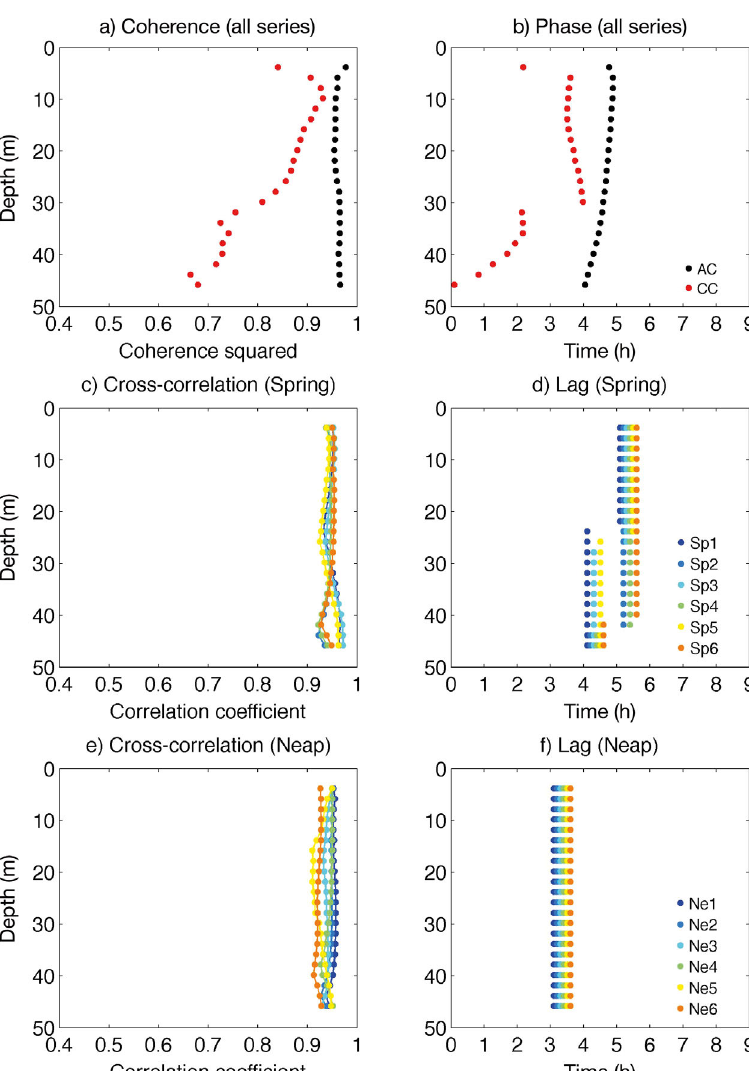
Fig. 6. Statistical relationships between sea level and semidiurnal currents. (a,b) Analysis of coherence and phase using the complete time series for both components (AC: along-channel; CC: cross-channel). (c,d) Along-channel cross- correlation analysis during spring tides. (e,f) Along-channel cross-correlation analysis during neap tides. Sp1 to Sp6: chronologically, the 6 spring tides of the series. Ne1 to Ne6: chronologically, the 6 neap tides of the